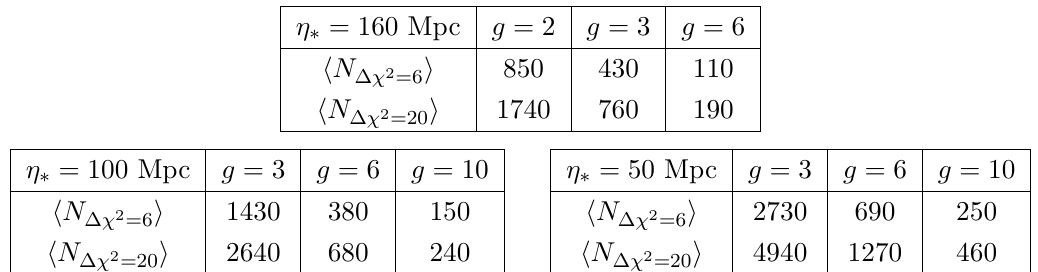
Table 2 . Minimum numbers of signals h N excess based on the goodness-of-fit test using C TT